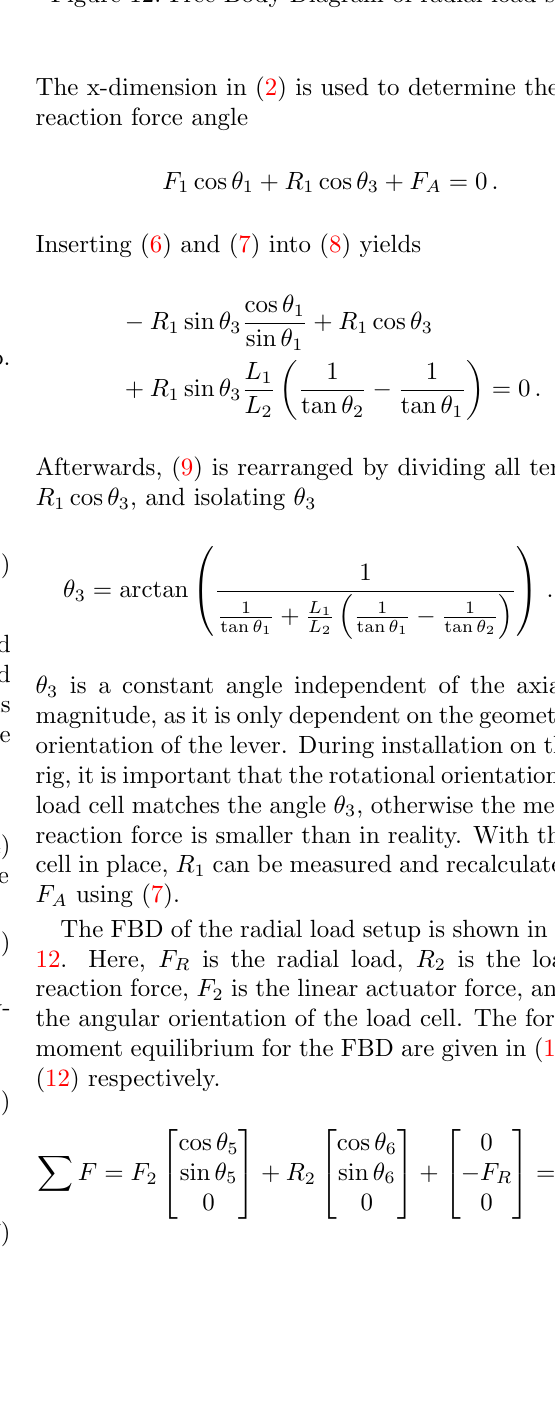
Figure 12: Free Body Diagram of radial load